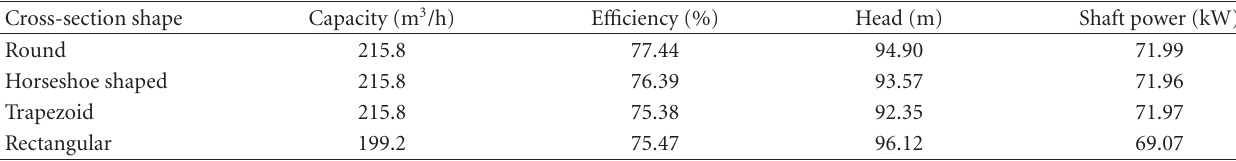
Table 3: List of pump BEPs at di ff erent volute cross-section shapes.